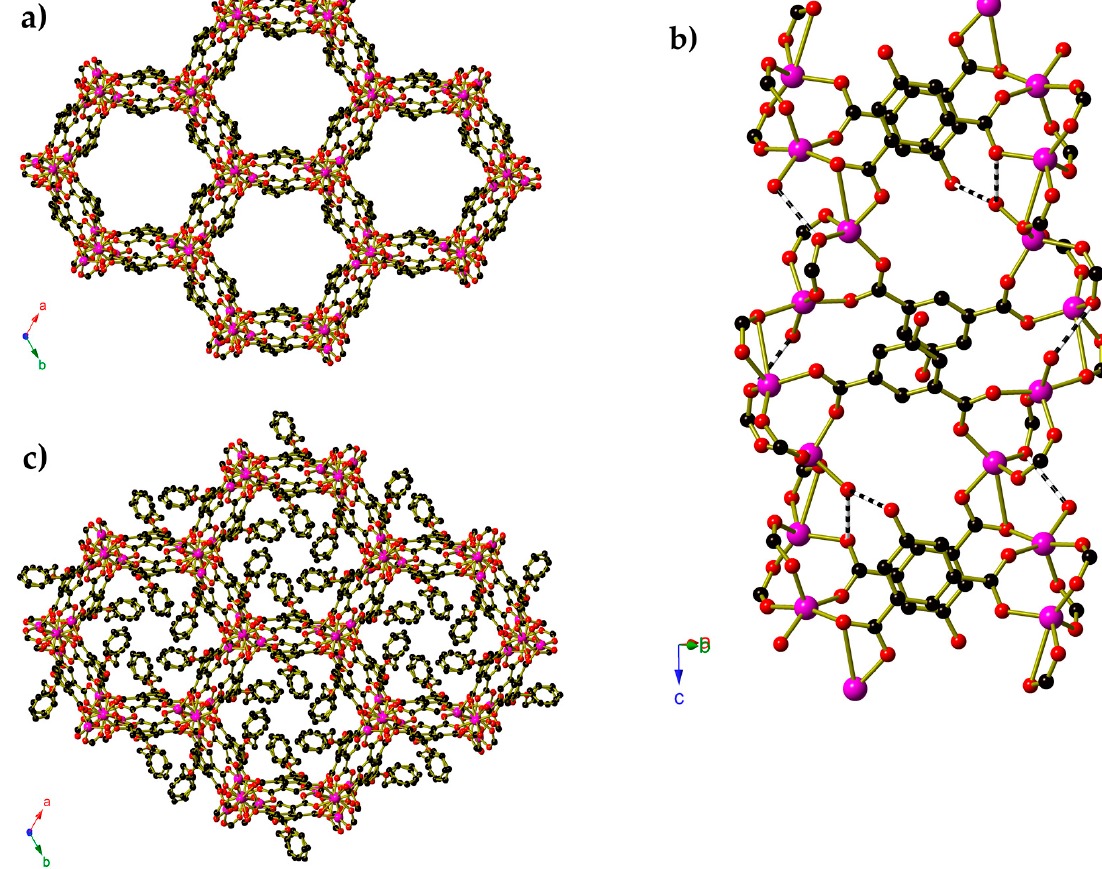
Figure 2. ( a ) A view along the c -axis of the honeycomb frameworks of Co 2 (BzOip) 2 (H 2 O) in which the benzyloxy groups have been removed for clarity; ( b ) one segment of the framework wall panels in Co 2 (BzOip) 2 (H 2 O), with the benzyl groups removed for clarity; and ( c ) a view of the full framework of Co 2 (BzOip) 2 (H 2 O).